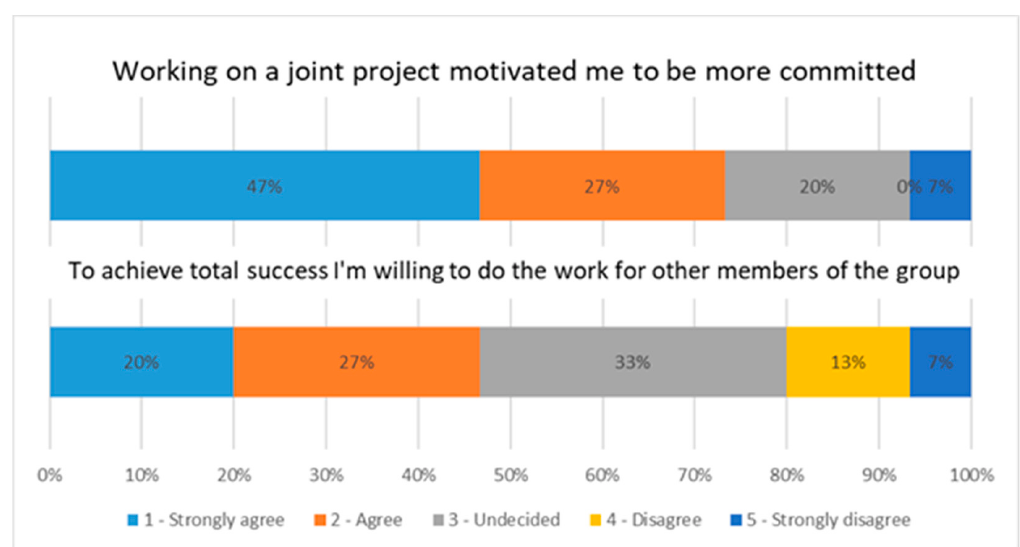
Figure 8. Expression of students’ attitudes to the statements “Working on a joint project motivated me to be more committed” and “To achieve total success, I am willing to do the work for other members of the group”.